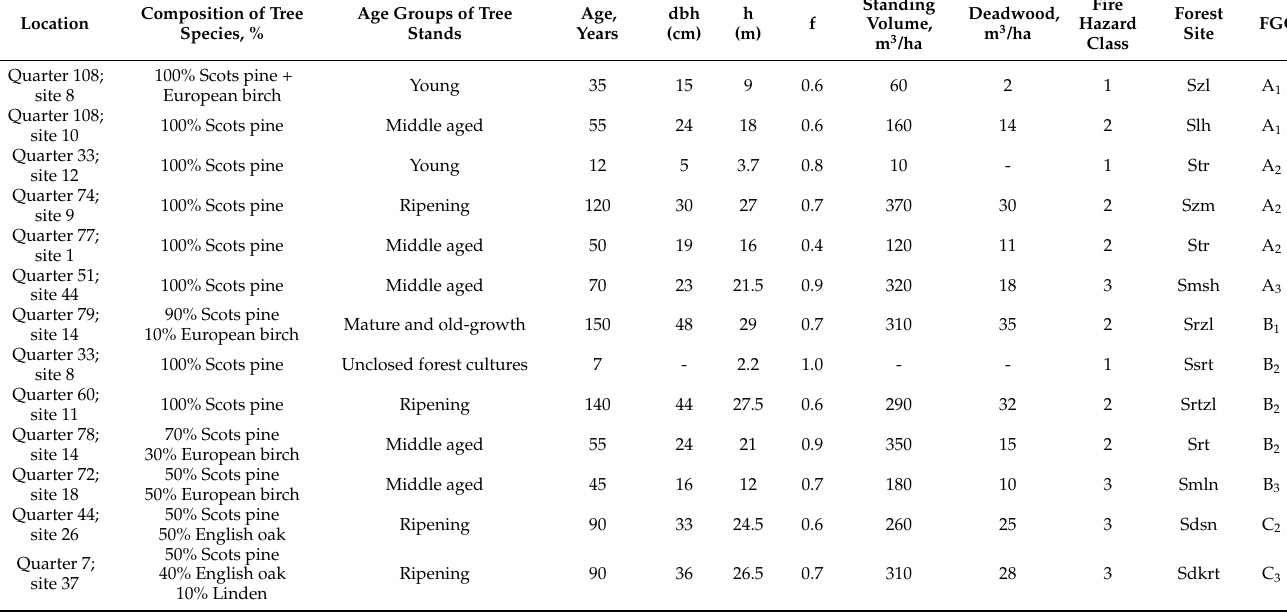
Table 1. Studied forest stand characteristics and their fire hazard classes.